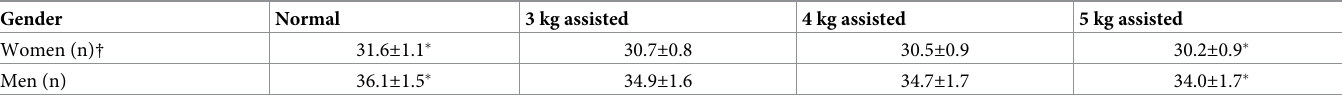
� indicates a significant difference with all other conditions on a p < 0.05 level.